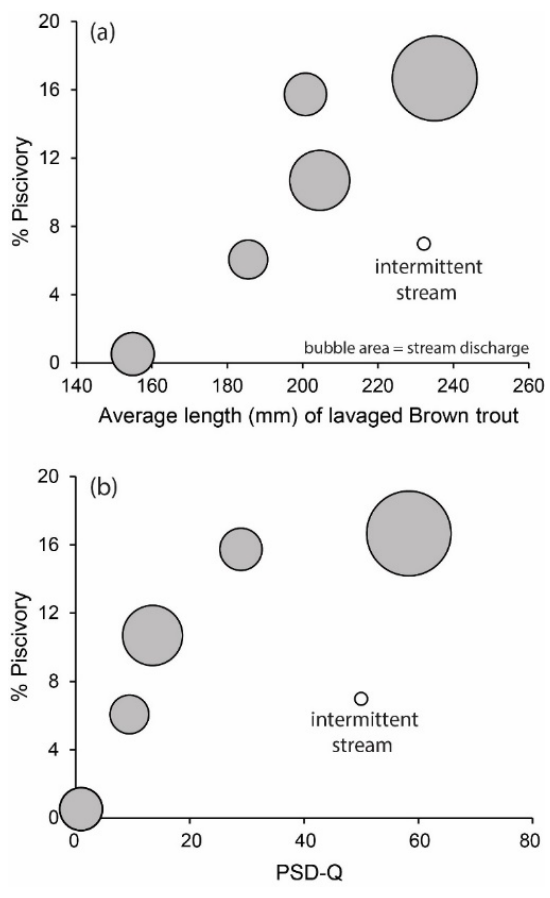
Figure 2. Percentage of piscivory by Brown Trout ( Salmo trutta ) in relation to the ( a ) average body length of lavaged fish and ( b ) population size structure (PSD-Q). Bubble sizes represent average stream discharge among study sites.